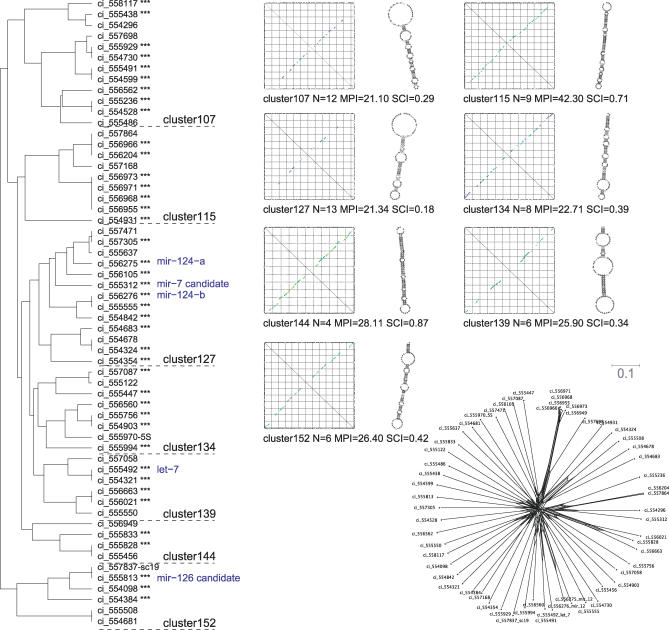
Cluster Containing Known and Predicted C. intestinalis microRNAsThe two known mir-124 paralogs are members of subcluster 127, whereas the known let-7 is found in subcluster 139. Sequence ci_555813 in subcluster 152 contains a mir-126 candidate (UCGUACCGUGAGUAAUAAAGC) and ci_555312 in subcluster 127 a mir-7 candidate (UGGAAGACUAGUGAUUUUGUUGU). Forty of the 58 cluster members (marked with ***) are classified as putative microRNAs by RNAmicro [37]. The fourth known microRNA in urochordates, mir-92, does not fall into this structural cluster. Members of the cluster are not sequence related (NeighborNet in the bottom right corner). N, number of sequences in cluster.